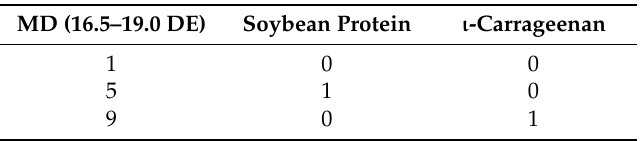
Table 2. Ratios of coating agents (g/g) employed for the encapsulation of lemon by-product extracts by spray or